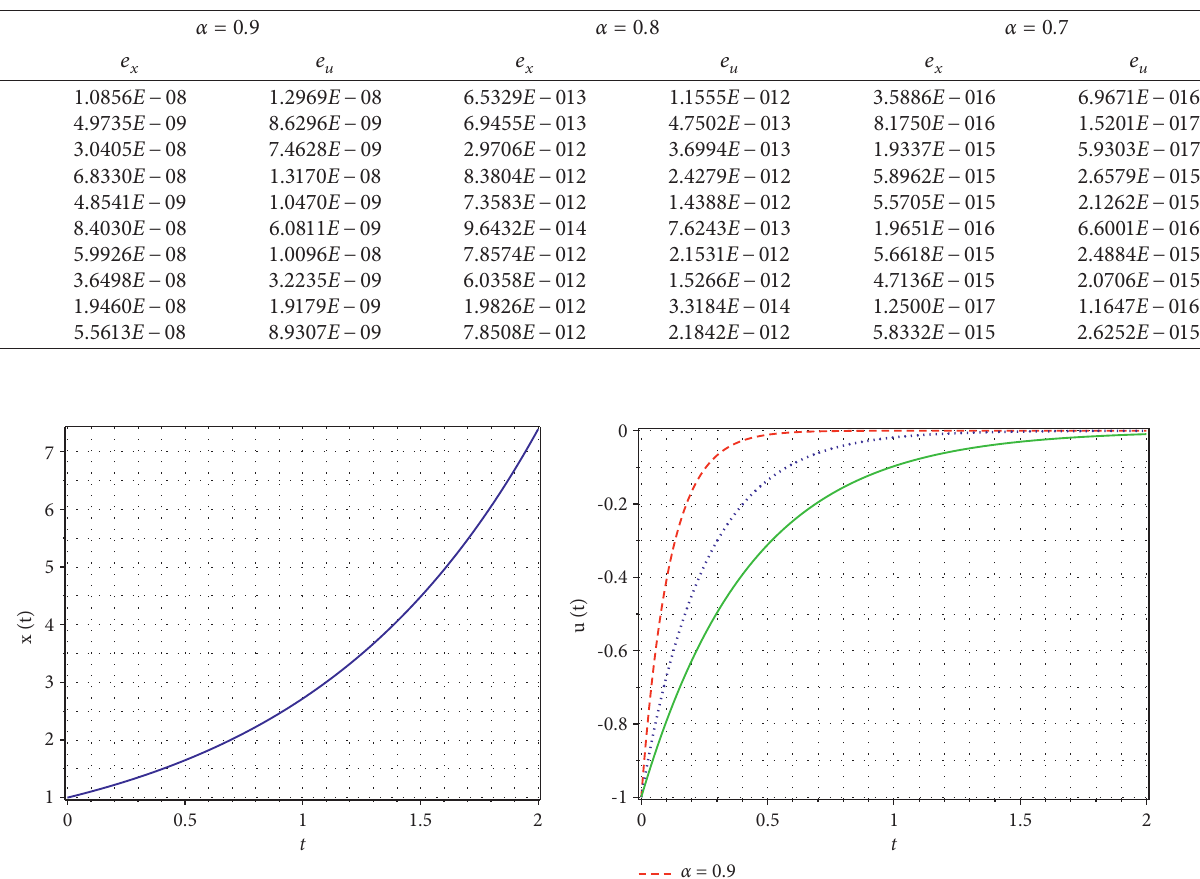
Table 4: Absolute errors of x ( . ) and u ( . ) with N � 15 in Example 3.